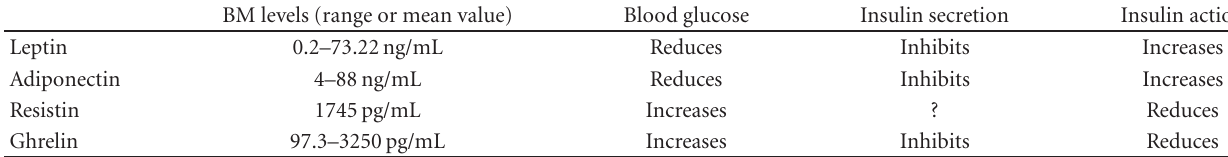
Table 1: Breast milk (BM) hormones and their action on glucose homeostasis.